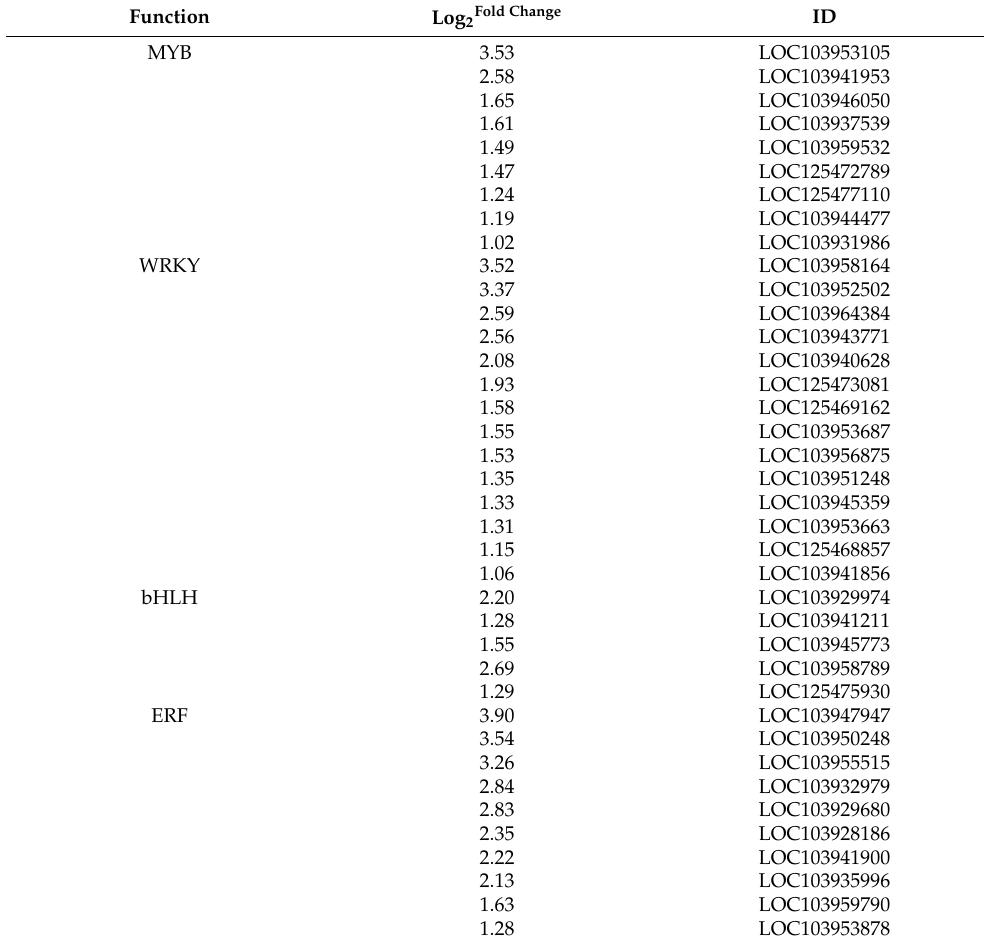
Table 5. Expression levels of transcription factor